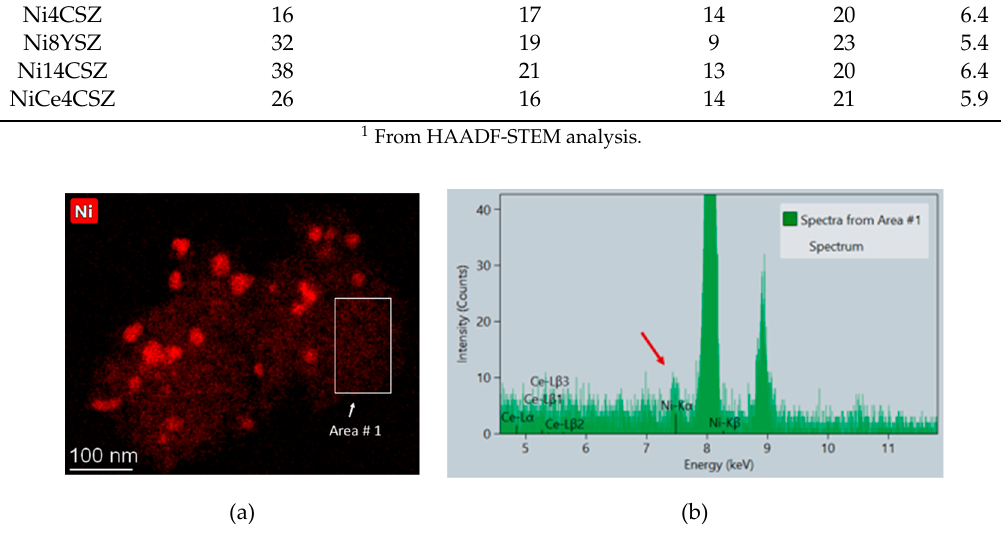
Figure 7. EDS analysis corresponding to Ni4CSZ: ( a ) Ni mapping; ( b ) spectrum from the area indicated in the image.